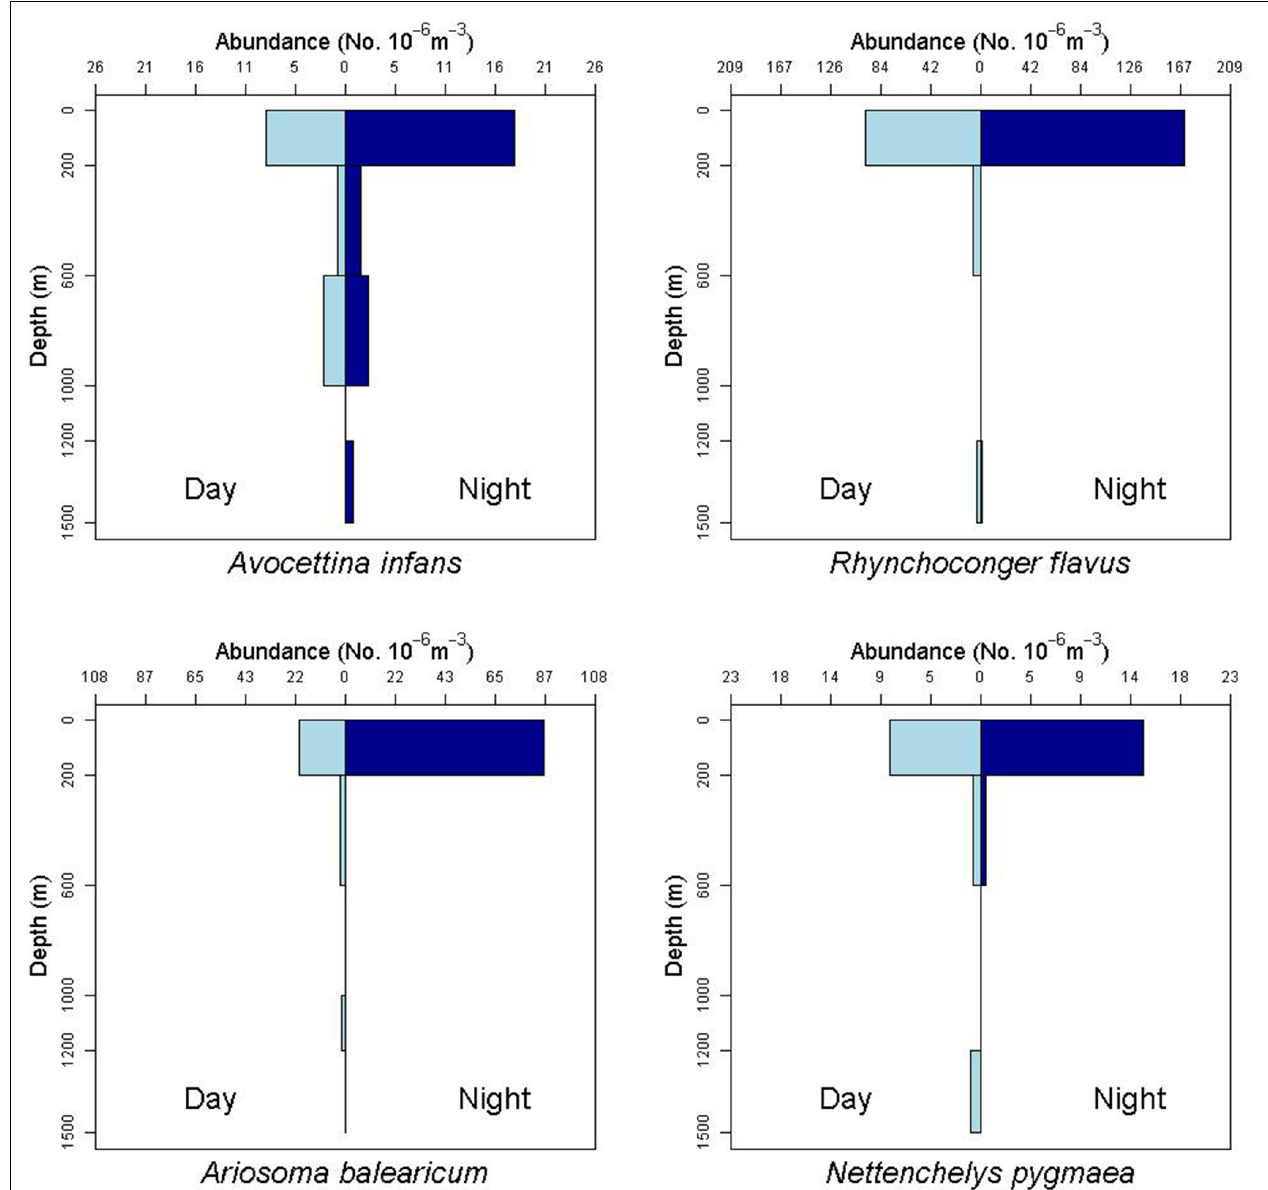
FIGURE 8 | Depth profile of the leptocephalus for the nemichthyid species Avocettina infans , showing a distribution down to 1500 m depth and possible net avoidance at the surface. The profile of the congrid leptocephalus of Rhynchoconger flavus also shows captures at 1200–1500 m. The profile of the congrid Ariosoma balearicum shows captures down to 1200 m during the day. The profile for the synaphobranchid species Nettenchelys pygmaea also shows daytime captures down to 1500